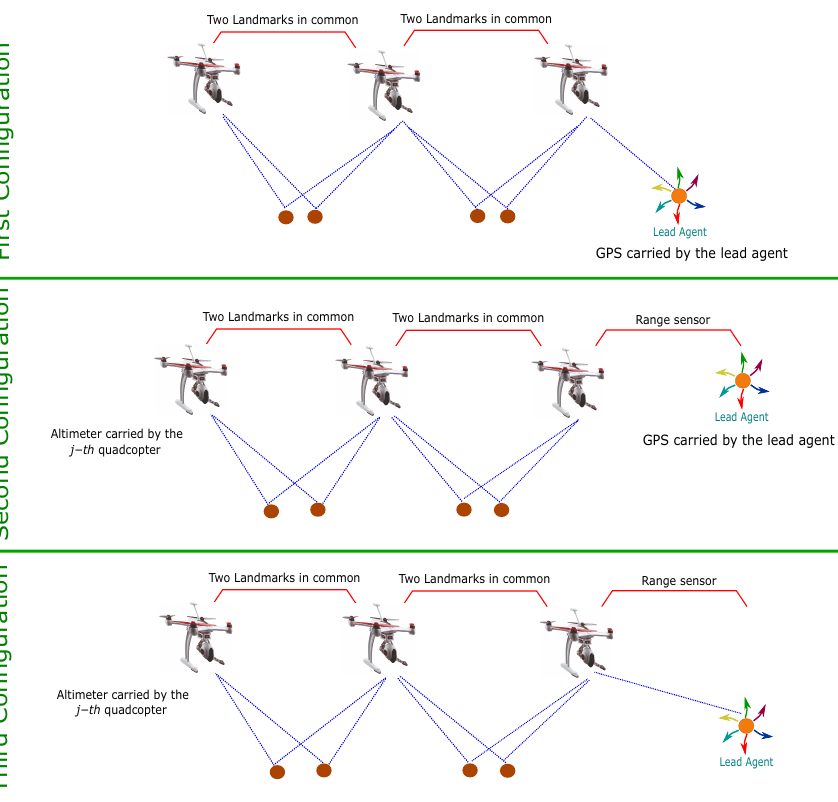
Figure 4. System configurations and minimum requirements for obtaining the results of the observability analysis.